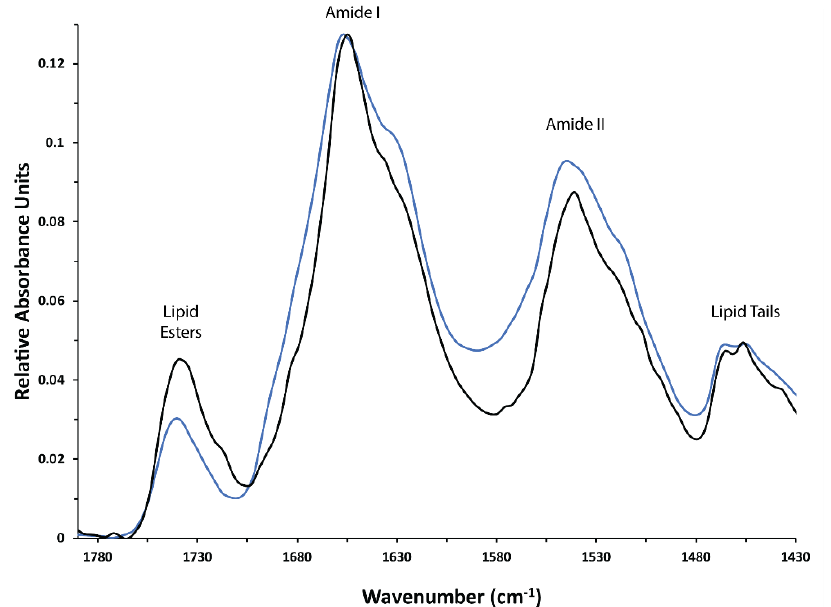
Figure 3. FTIR spectra of hAQP2 reconstituted into heart polar lipids at the target protein / lipid ratio of 2:1 (w/w). hAQP2 expression in P. pastoris was induced at 30 ° C (blue trace) and at 20.5 ° C (black trace). Characteristic bands are labeled.